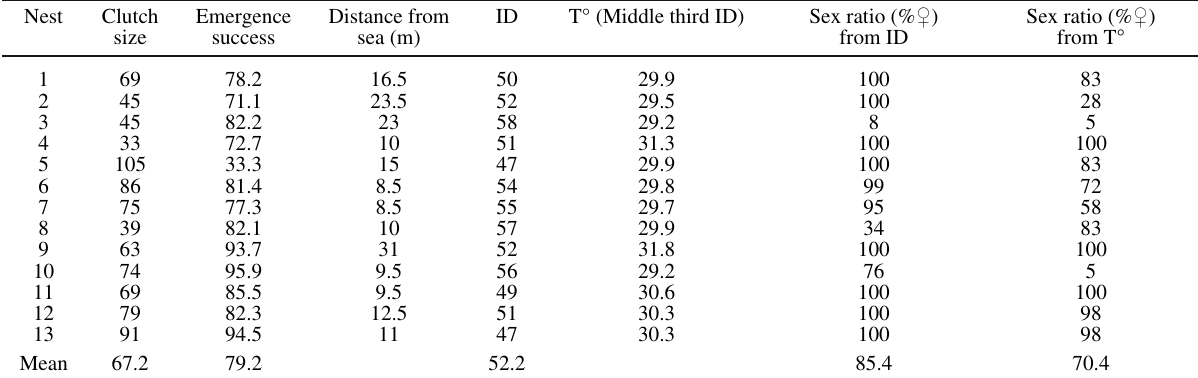
Table 6. – Information on nests, incubation duration and temperature data with the estimated sex ratio (% ♀ ). ID, incubation duration. Nest Clutch Emergence Distance from size success sea (m)